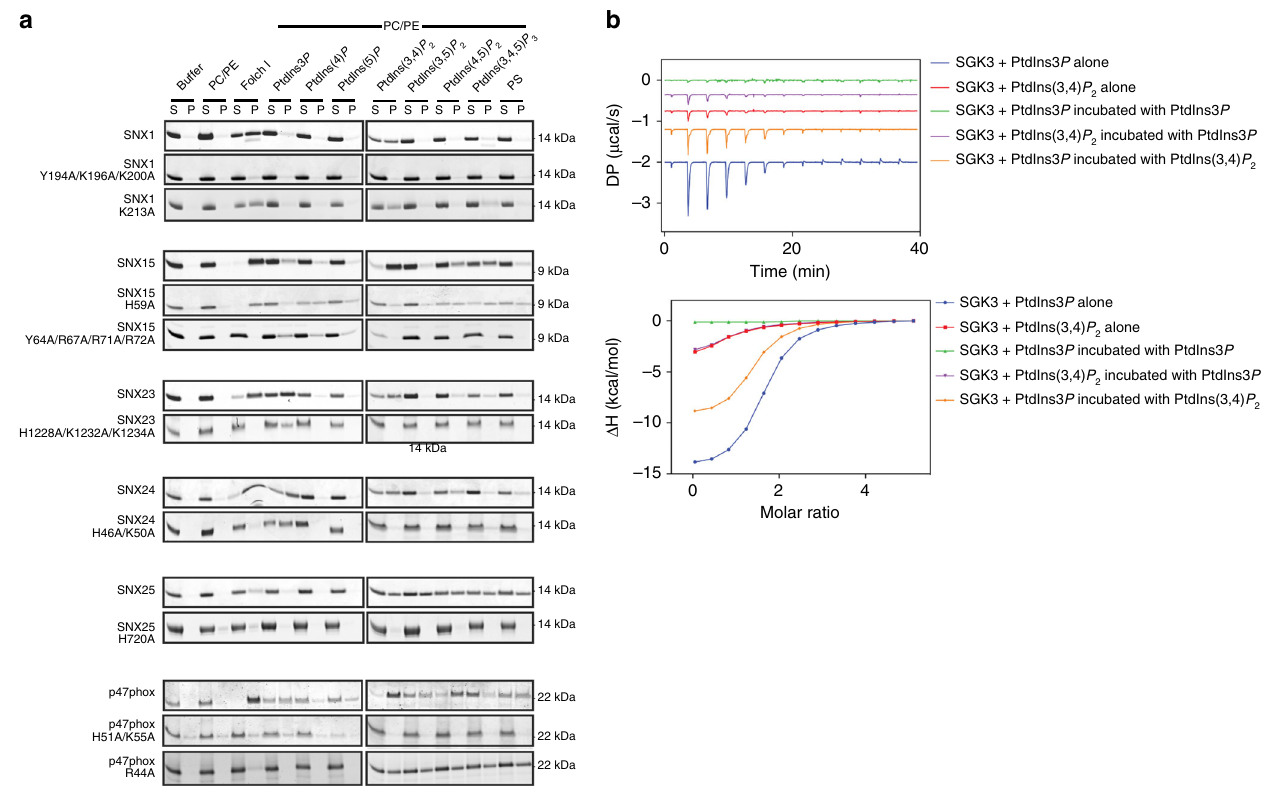
Fig. 7 Mutagenesis of canonical and noncanonical sites in PX domain proteins. a Selected bacterially expressed and puri fi ed PX domains and their mutants with GST tags removed were incubated with arti fi cial liposomes as indicated. Liposomes included POPC/POPE (PC/PE) as a negative control, Folch I as an indicator of broad membrane-binding activity, or PC/PE liposomes containing the speci fi c lipids PtdIns3 P , PtdIns4 P , PtdIns5 P , PtdIns(3,4) P 2 , PtdIns(3,5) P 2 , PtdIns(4,5) P 2 , PtdIns(3,4,5) P 2 , or PS. Samples were subjected to ultracentrifugation followed by SDS-PAGE and Coomassie staining of the unbound supernatant ( S ) and bound pellet ( P ) fractions. b Water-soluble PtdIns3P and PtdIns(3,4) P 2 headgroup analogues (500 μ M) were titrated into the